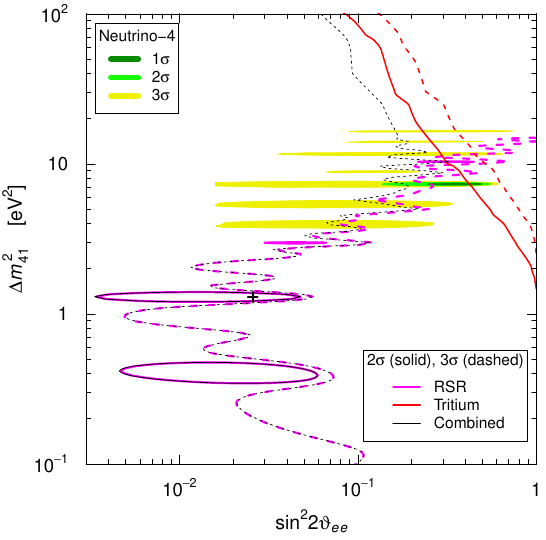
Figure 6 . 2 (cid:27) and 3 (cid:27) bounds in the (sin 2 2 # ee ; (cid:1) m 2 ) plane obtained from the combined analysis 41 of the data of the Mainz, Troitsk and KATRIN tritium experiments and the combined analysis of the reactor spectral ratio (RSR) measurements of the Bugey-3, NEOS, PROSPECT and DANSS experiments. Also shown are the combined tritium and reactor spectral-ratio bounds (with the best (cid:12)t indicated by the black cross) and the regions allowed at 1 (cid:27) , 2 (cid:27) , and 3 (cid:27) by the results of the Neutrino-4 reactor experiment